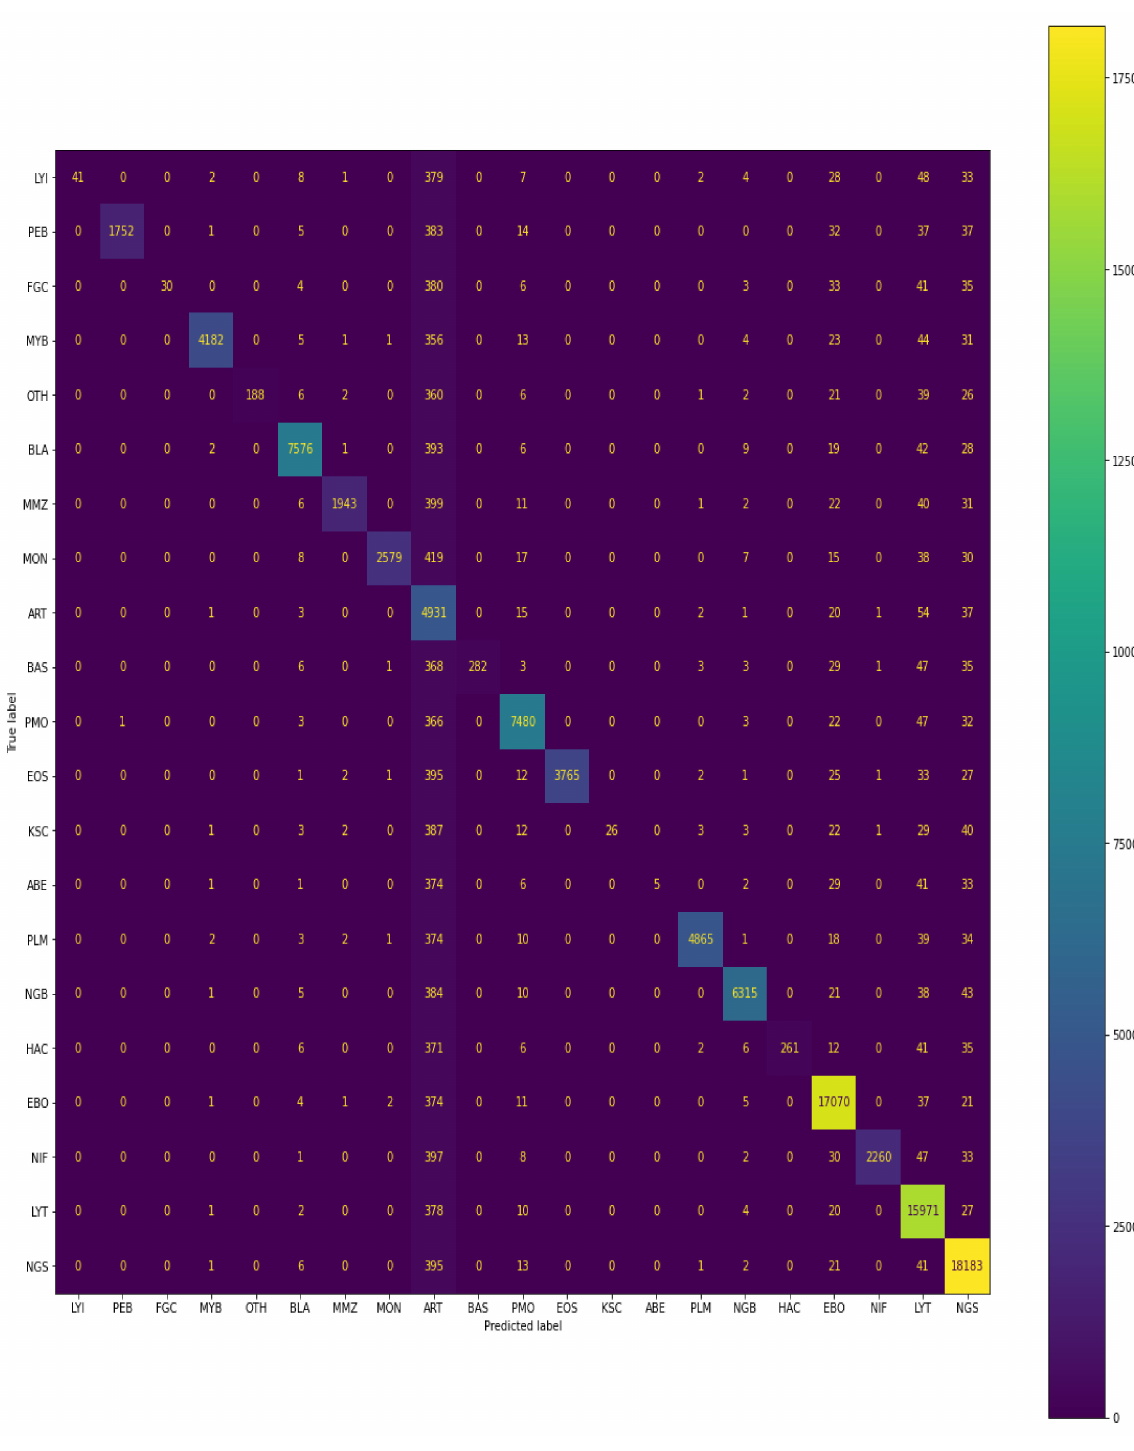
Figure 12. Confusion matrix of predictions generated by Siamese model on training data. According to the confusion matrix shown, the model correctly classifies 41 images out of 41, 1752 images out of 1753, 30 images out of 30, 4182 images out of 4196, 188 images out of 188, 7576 images out of 7662, 1943 images out of 1955, 2579 images out of 2585, 4931 images out of 12,563, 282 images out of 282, 7480 images out of 7676, 3765 images out of 3765, 26 images out of 26, 5 images out of 5, 4865 images out of 4882, 6315 images out of 6379, 261 images out of 261, 17,070 images out of 17,532, 2260 images out of 2264, 15,971 images out of 16,794, and 18,183 images out of 18,831 for each class,